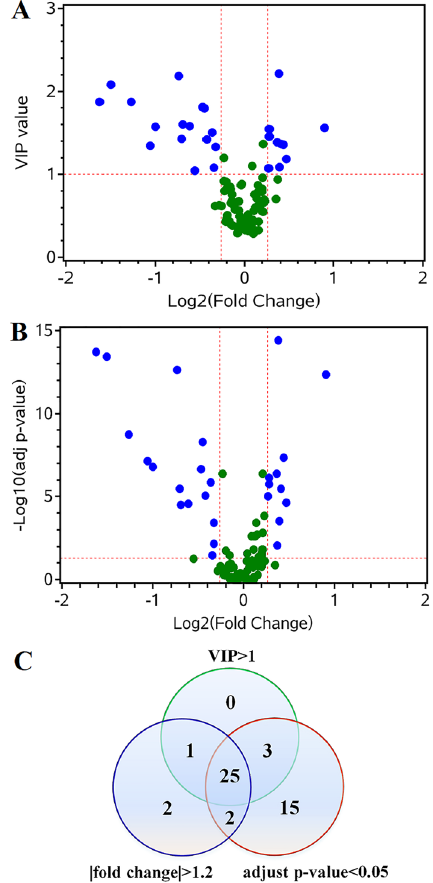
Figure 3. Identification of potential biomarkers for distinguishing patients with GC from healthy individuals in training set. ( A ) The plot of VIP value versus fold change (FC). The differential metabolites were defined with VIP > 1 and FC > 1.2 or < -1.2 between patients with GC and healthy individuals. The selected metabolites were colored in blue. ( B ) The plot of adjusted p -value versus FC. The changed metabolites were displayed with adjusted p -value < 0.05 and FC > 1.2 or < -1.2 in patients with GC compared to healthy individuals. ( C ) Venn diagram demonstrates differential metabolites in GC group compared with healthy group. Twenty-five differential metabolites were selected with VIP > 1 and adjusted p -value < 0.05 and FC > 1.2 or < − 1.2.